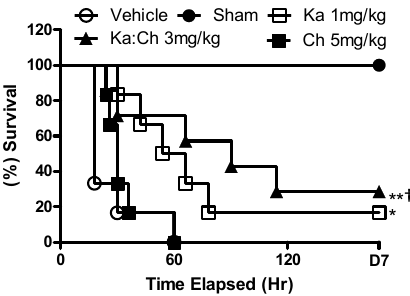
Figure 2. Effects of combinatorial treatments on the survival rate (%) of CLP-challenge septic mice within 7 days. CLP/Vehicle (2% DMSO and 5% Tween-20/phosphate-buffered saline (PBS)) ( ○ ); Sham ( ● ); CLP/Ka:Ch 3 mg/kg ( ▲ ); CLP/Ka 1 mg/kg ( □ ); CLP/Ch 5 mg/kg ( ■ ). Animals were i.p. injected with treatments or vehicle (10 mL/kg) 1 h prior to CLP challenge, * p ≤ 0.01 and ** p ≤ 0.005 versus CLP/vehicle, † p = 0.05 versus CLP/Ch chi-square and log-rank test).